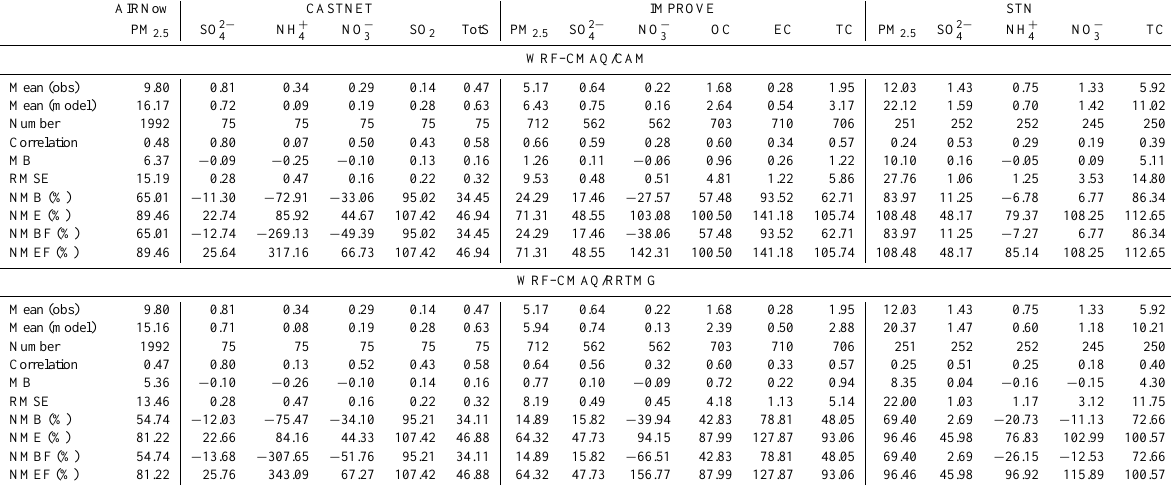
Table 7b. The same as Table 5b, but for September of 2006 for